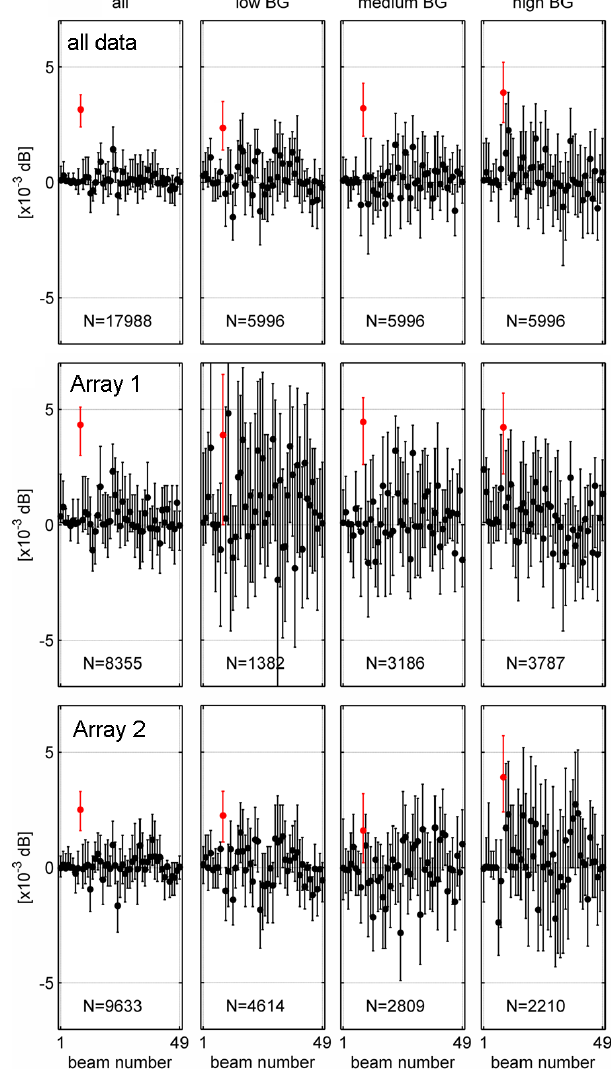
Fig. 8. Medians of the observed absorption differences, with 95% bootstrap error bars, for all IRIS beams. Beam 9 is shown in red. Upper line: All selected experiments. Middle line: EISCAT Heater antenna field 1 experiments. Lower line: Antenna field 2 experi- ments. Leftmost column: All data. Other columns: Selected data from the three categories of background